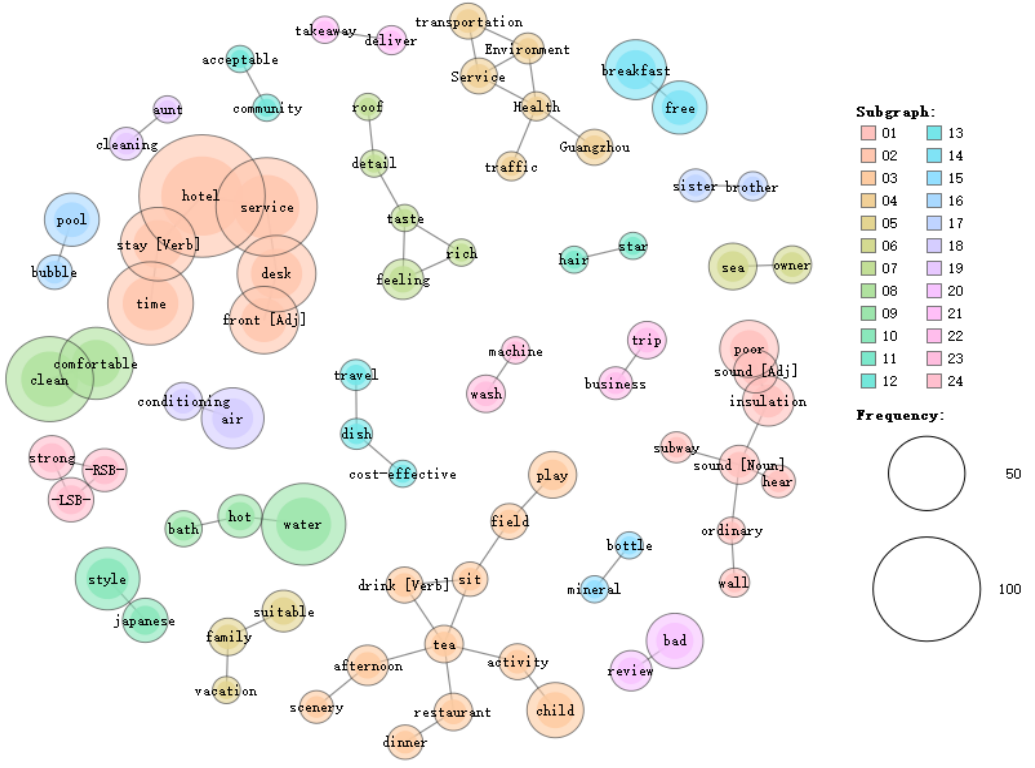
Figure 3. Co-existing semantic network distribution map.